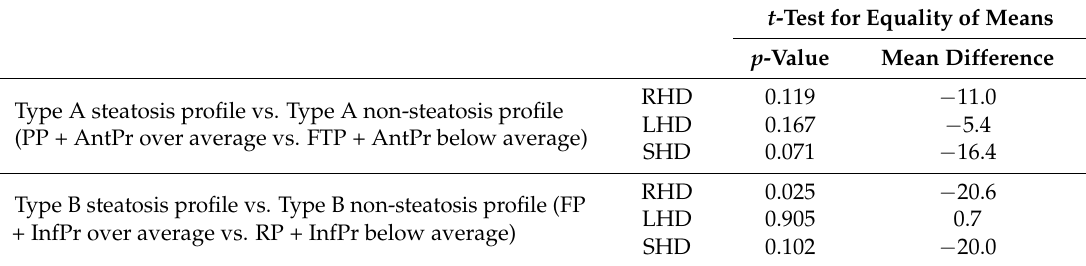
t -Test for Equality of Means p -Value Mean Difference RHD